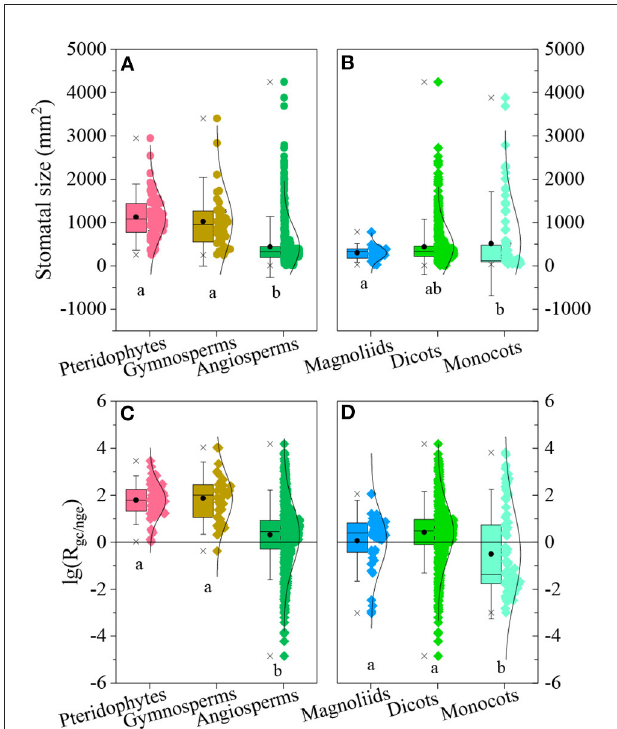
FIGURE 5 | Ratio of the geometric constraint to non-geometric effect [lg( R gc / nge )] and values of stomatal size (SS) and lg( R gc / nge ) for different species groups. (A,B) : SS among pteridophyta, gymnosperm, and angiosperm species (A) and among magnoliids, dicots, and monocots (B) ; boxes represent 25, 50, and 75% of the ranges; bars represent 1.50 times the standard deviation; two stars and circles indicate the minimum, maximum, and mean value, respectively. Different letters indicate that the variation was significant at p < 0.05. (C,D) : lg( R gc / nge ) values among pteridophyta, gymnosperm and angiosperm species (C) and among magnoliids, dicots, and monocots (D)